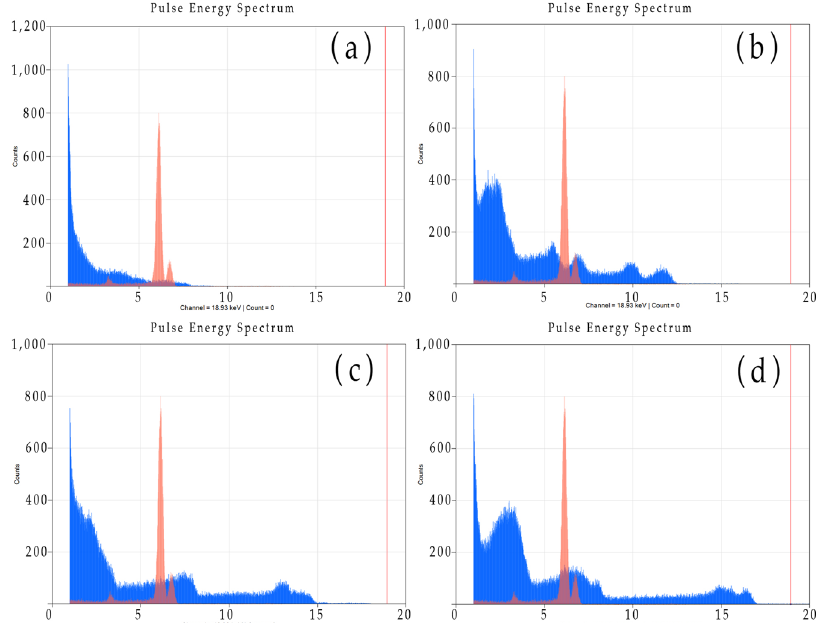
Fig. 2 Blue spectrum is photon emissions during operations. Red spectrum is radioactive 55 Fe calibration sample in reference to device. a At 1 min shows strong 1 KeV emission lines at start-up with a gradual envelope falloff towards 7.5 KeV 8 . Spectrum b after 2 min of operations shows substantial envelope growth in photonic values at 3.5 KeV, 5.7 KeV, 6.1 KeV, 10.2 KeV and 12.5 KeV. Spectrum c after 6-h shows an even further widening of the photon emissions with distinct peaks at 1 KeV, 6.6 KeV and 14 KeV shown as dominant. It appears that maximum tapered out emissions were detected approximately between 14 and 17 KeV. Spectrum d after eight hours shows the highest maximum emission value at 18.93 KeV (RED vertical line) with strong peaks between 3.55 KeV, 6.3 Kev, 15 Kev and ~18 KeV. RED spectrum on the graphs shows the radioactive 55 Fe calibration sample. Note: BLUE Spectrum values ( a – d ) are from FW experiments and the S/ST304 electrodes. See Supplemental Fig. 3 for SW experiments.